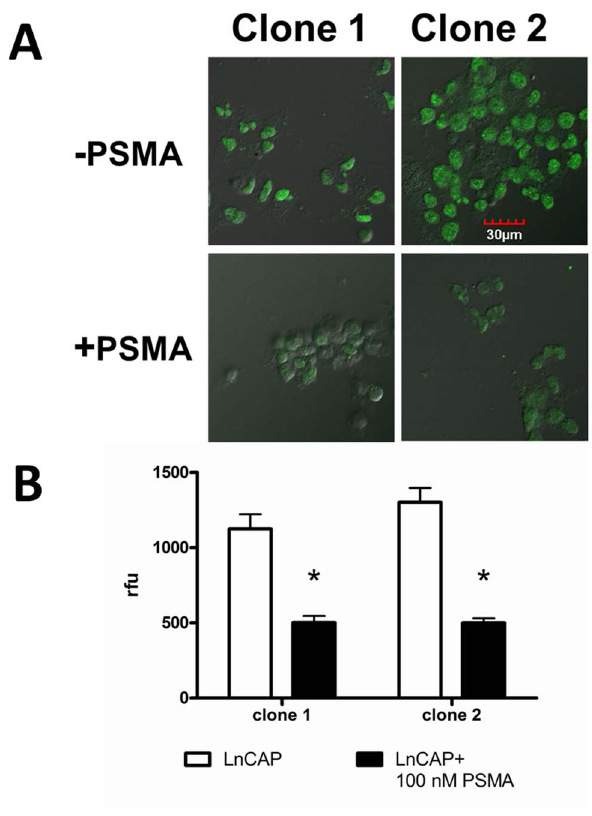
Figure 2. Immunofluorescence microscopy of phage clones from round 2 of panning. (A) PSMA (100 nM) inhibited the binding of Clone 1 (ARLSHRPSYLLVCA) and Clone 2 (GTAVASRVYSLHSLM) to PSMA-postive LNCaP cells, indicating that the uptake was receptor specific (scale is 30 m m). (B) Immunofluorescence microscopy of phage clones from round 2 of panning indicate that the panning process is biased toward PSMA binding (‘‘*’’ denotes P , 0.05 ).